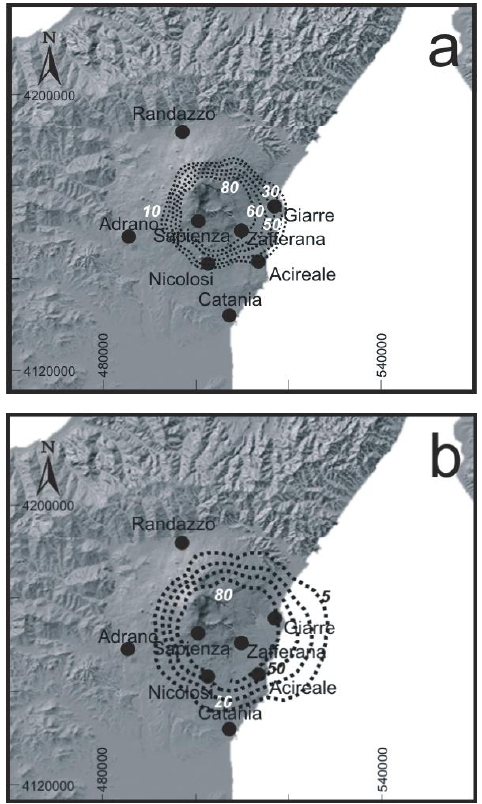
Fig. 13. Eruption duration (days) sampled for the eruption range Figure 13. Eruption duration (days) sampled for the Eruption Range Scenario of long-lived eruptions 692 scenario of long-lived eruptions (ERS-WLL). 693